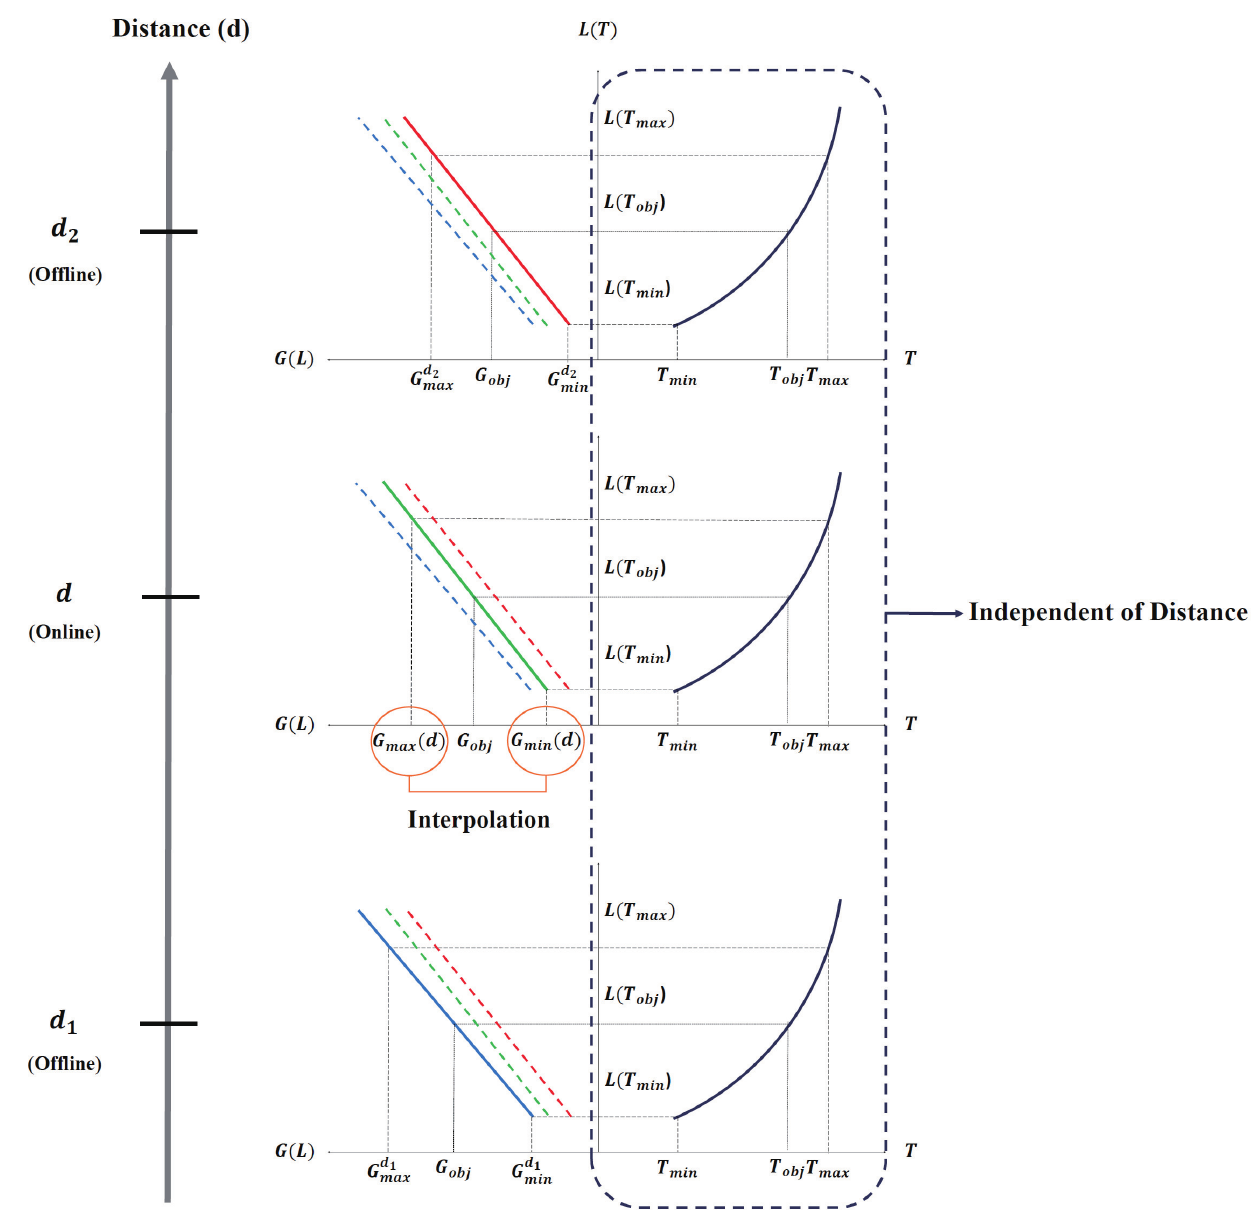
Figure 9. Redefined process the Radiation-Digital count mapping function according to distance through the pro- posed